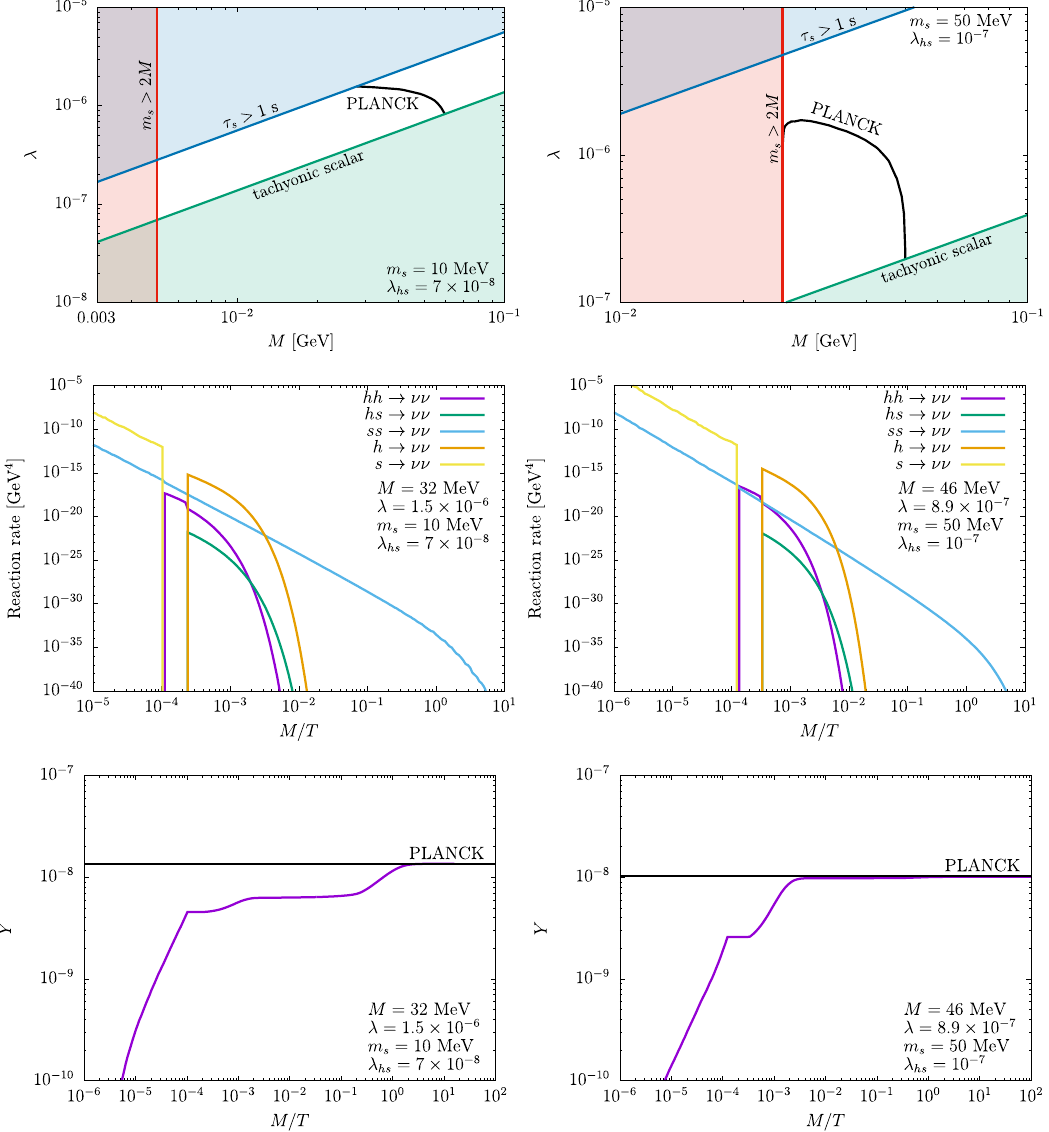
Figure 8 . Upper row: (cid:21) vs M producing the correct DM relic density (\PLANCK") for m s < 2 M . Middle row: Reaction rates for representative parameter sets. Lower row: DM yield for the above parameter sets. Left: ss ! (cid:23)(cid:23) and s ! (cid:23)(cid:23) dominate. Right: h ! (cid:23)(cid:23) dominates. production mode. The corresponding rate scales as T 4 down to temperatures of order M